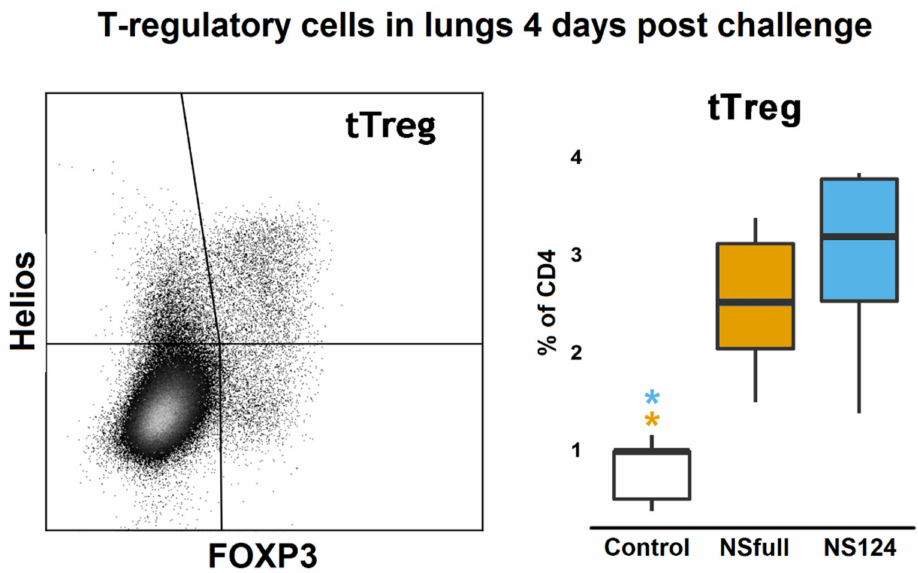
Figure 5. T-regulatory cells in the lungs of mice intranasally immunized with the A/PR8/NSfull and A/PR8/NS124 viruses after the heterologous challenge with the A/Aichi/2/68. The right plot represents the percentage of FOXP3 + Helios + T-regs in mouse lungs 4 d.p.c. *: p < 0.05. Groups were compared using ANOVA followed by Tukey’s post-hoc